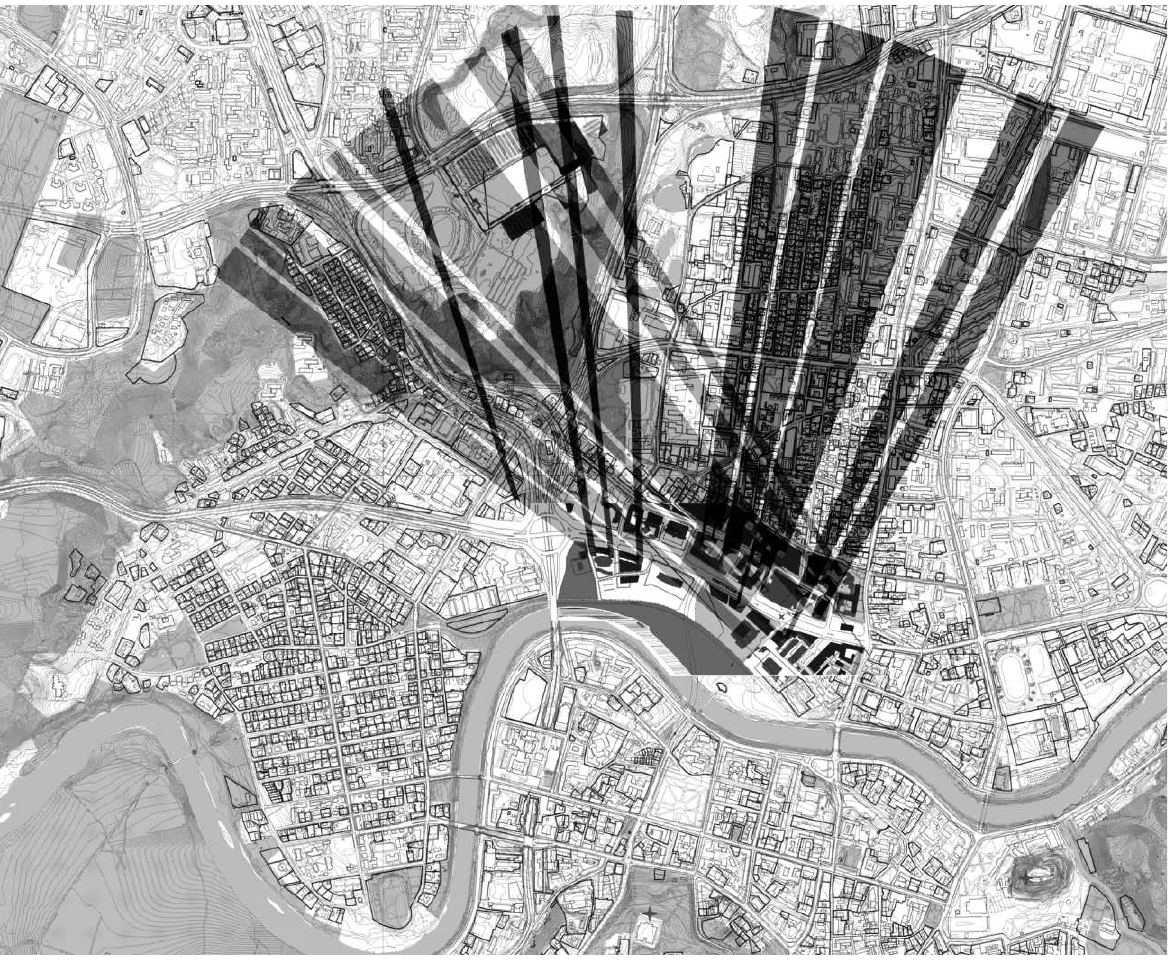
Fig 5. Analysis of “Akropolis” administrative building effect on the city’s visual identity (Research work of Department of Urban Design in VGTU,